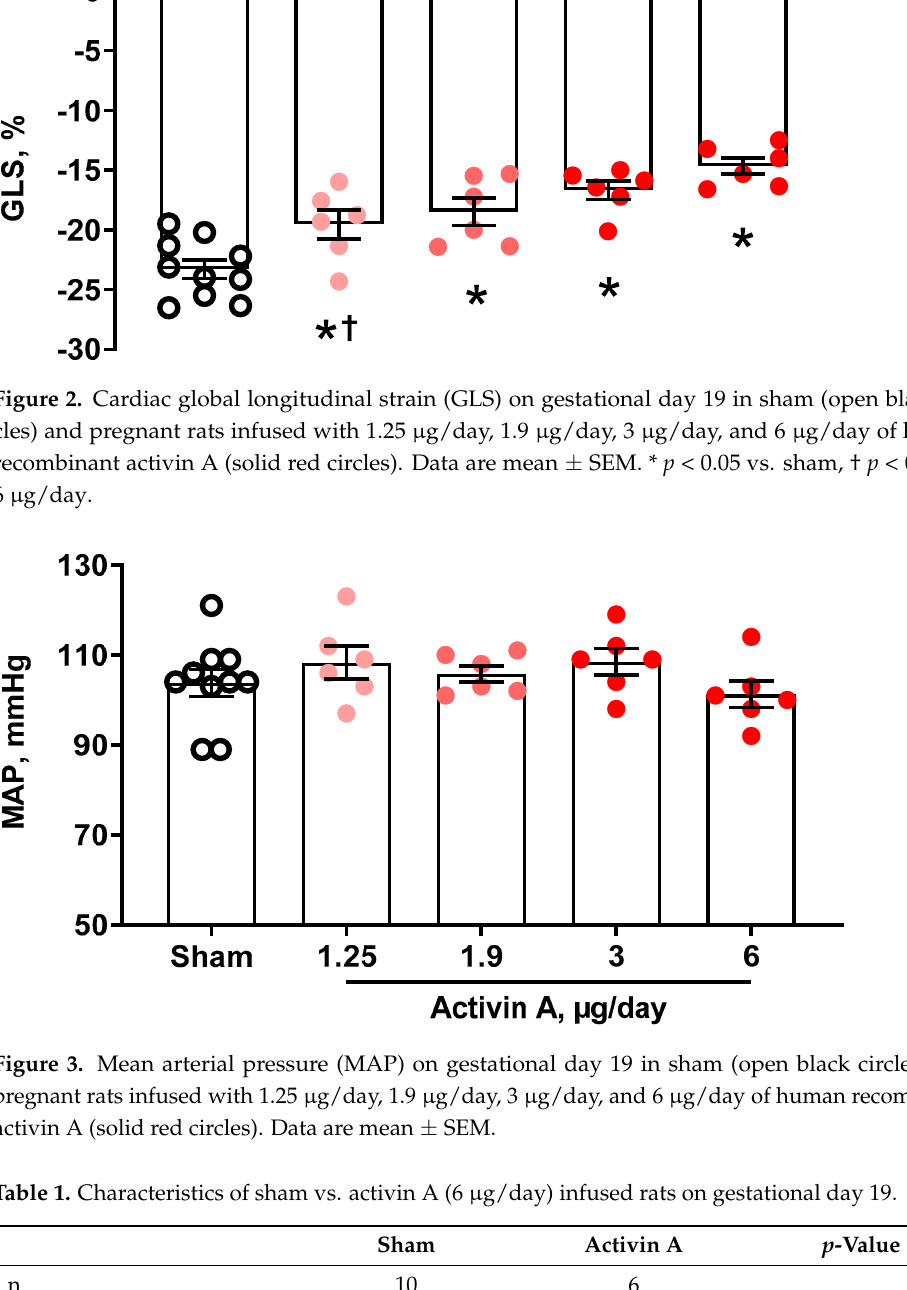
Table 1. Characteristics of sham vs. activin A (6 µg/day) infused rats on gestational day 19. Sham